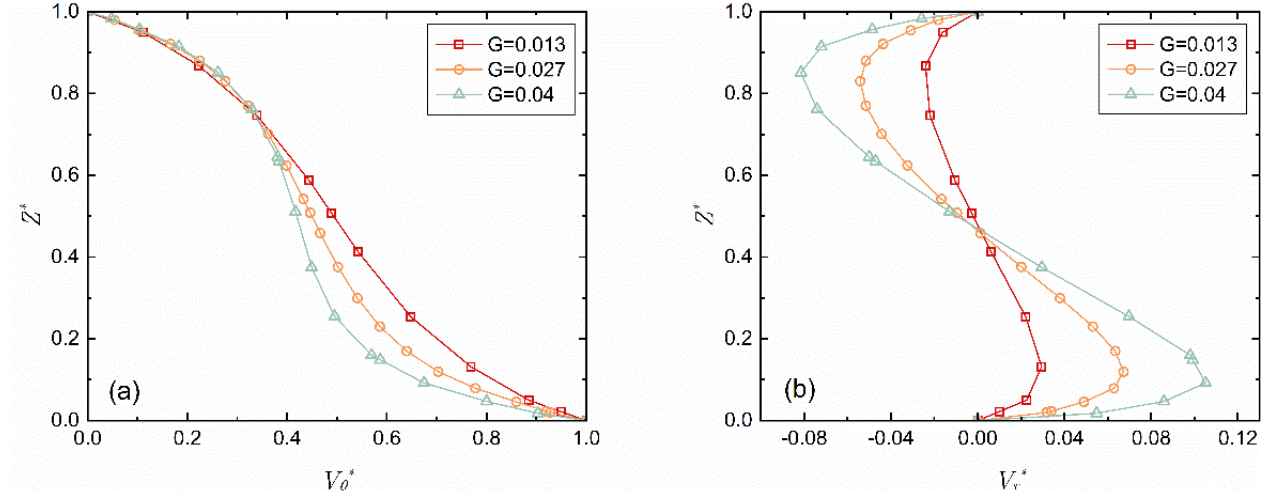
Figure 4. Distribution curve of the velocity component along the axis-z when r * = 0.8 and Re = 7.02 × 10 4 . ( a ) Circumferential velocity; ( b ) Radial velocity.